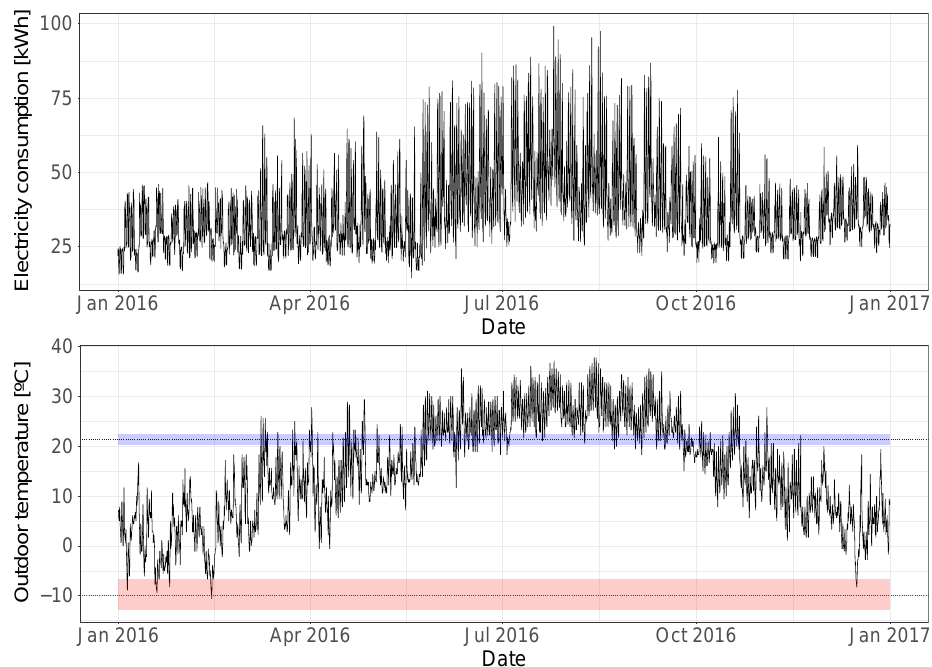
Figure 12. Electricity time-series vs. outdoor temperature values for the building Rat_health_Gaye . The heating and cooling change-point temperatures estimated by the model are shown in red and blue with the corresponding 94%